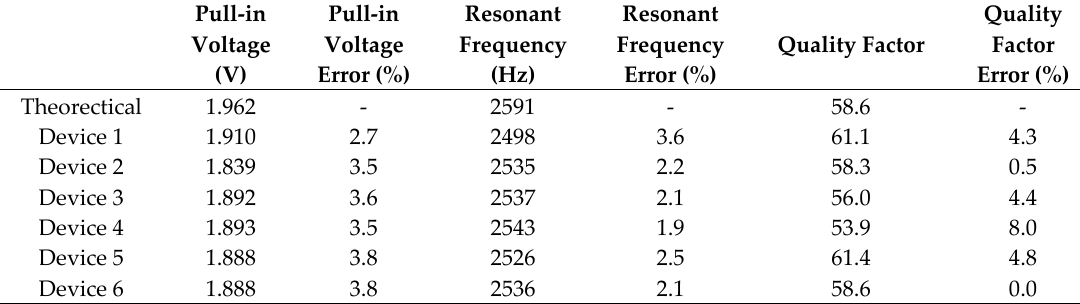
Table 1. Mechanical characterization of the fabricated devices.